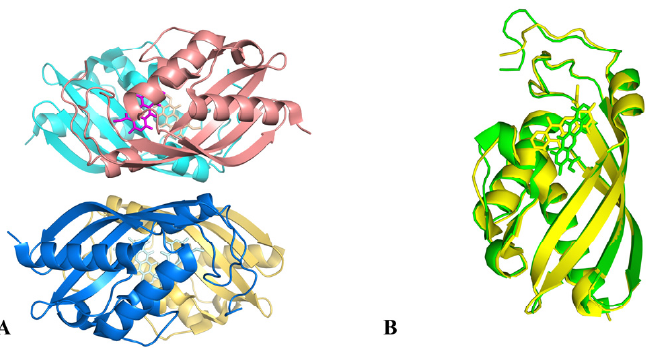
Figure 4. Structure information of AknH. ( A ) Structure of AknH; ( B ) Superimposition built by Pymol. AknH and SnoaL are shown in green and yellow, respectively.